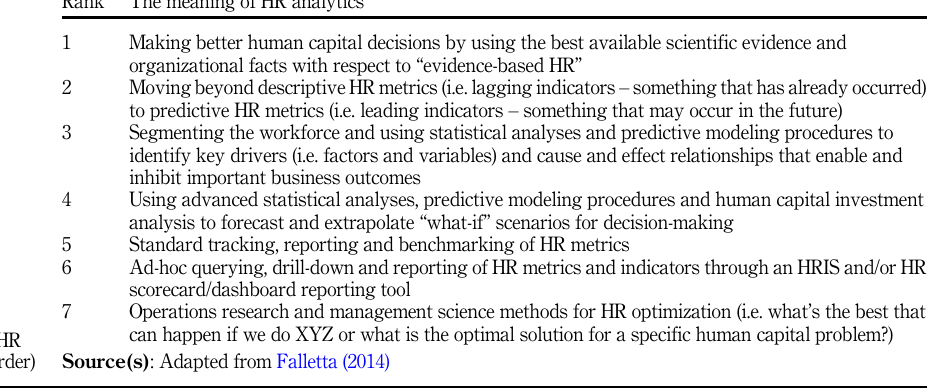
Table 1. The meaning of HR analytics (rank